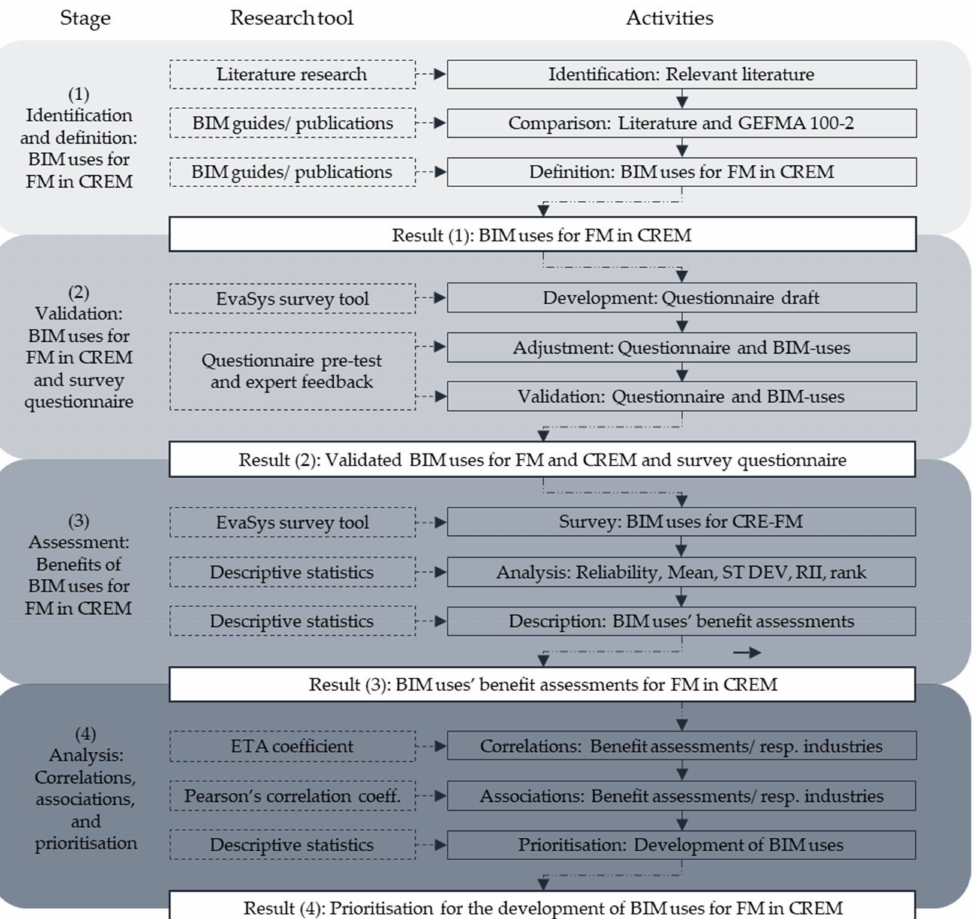
Figure 1. Research